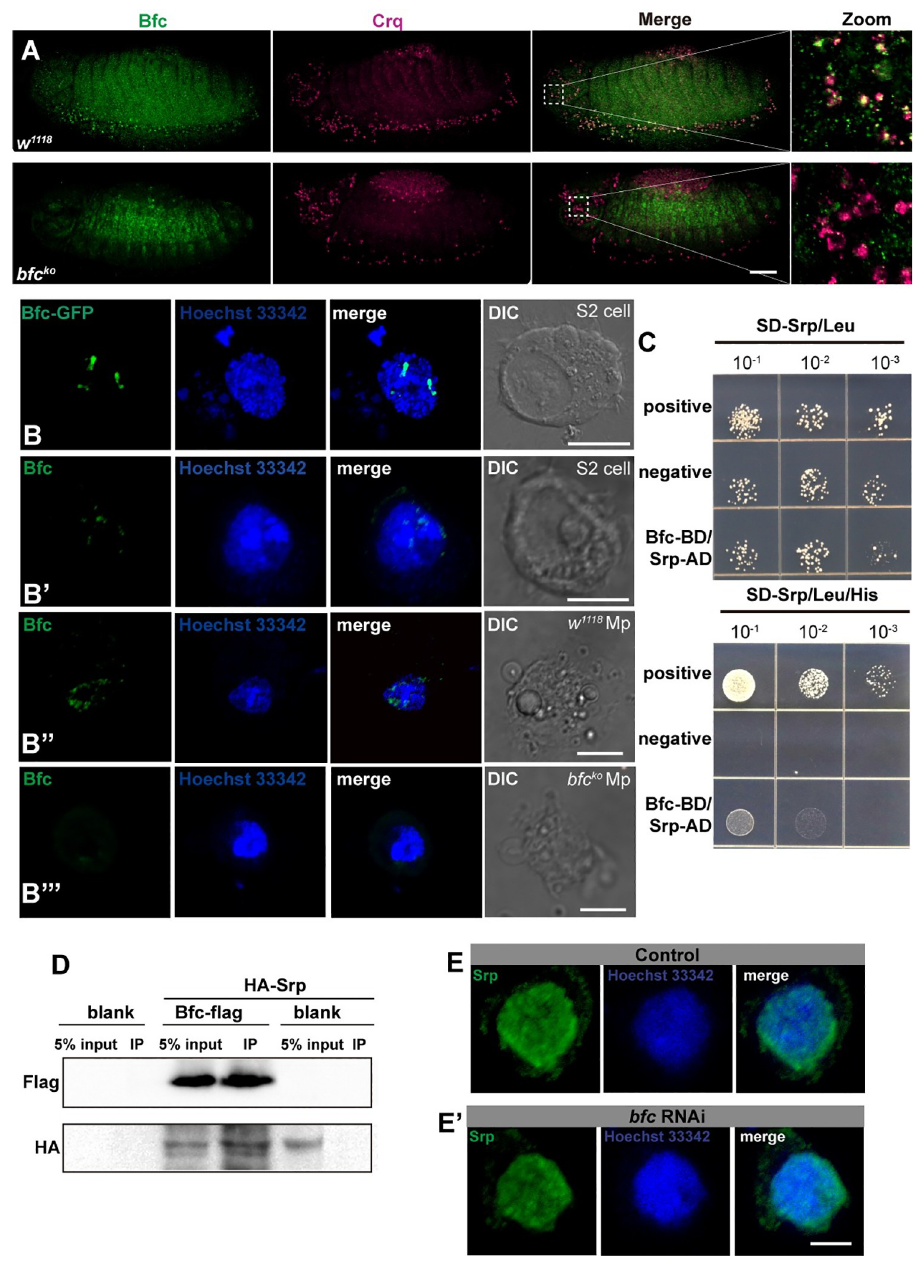
Fig 4. bfc is expressed in embryonic macrophages, and physically interacts with the GATA factor Srp. A. Macrophages of stage 13 w 1118 and bfc ko embryos were stained with anti-Crq (magenta) and anti-Bfc (green) antibodies. Scale bar = 20 μ m. B. Representative fluorescence pictures of the Bfc-GFP expression in S2 cells; B’-B”‘. Anti-Bfc (green) stained S2 cells (B’) ; macrophages (showed Mp for short in figure) isolated from w 1118 larvae (B”) and bfc ko larvae (B”‘) ; the nuclei were stained using Hoechst 33342 (blue). Scale bar = 5 μ m. C. Yeast two-hybrid assays to detect the interaction of Bfc (Bait) with Srp (Prey). Different concentrations of the labeled yeast transformants were grown on SD-Trp-Leu-His plates. D . Crude protein extracts from blank S2 cells, transiently transfected S2 cells expressing Bfc-Flag, and HA-Srp or HA-Srp alone were immunoprecipitated with anti-Flag magnetic beads. WB detection was performed using anti-Flag and anti-HA antibodies. E-E’. Anti-Srp (green) stained control S2 cells as well as bfc RNAi-treated S2 cells; the nuclei were stained using Hoechst 33342 (blue). Scale bar = 5 μ m.